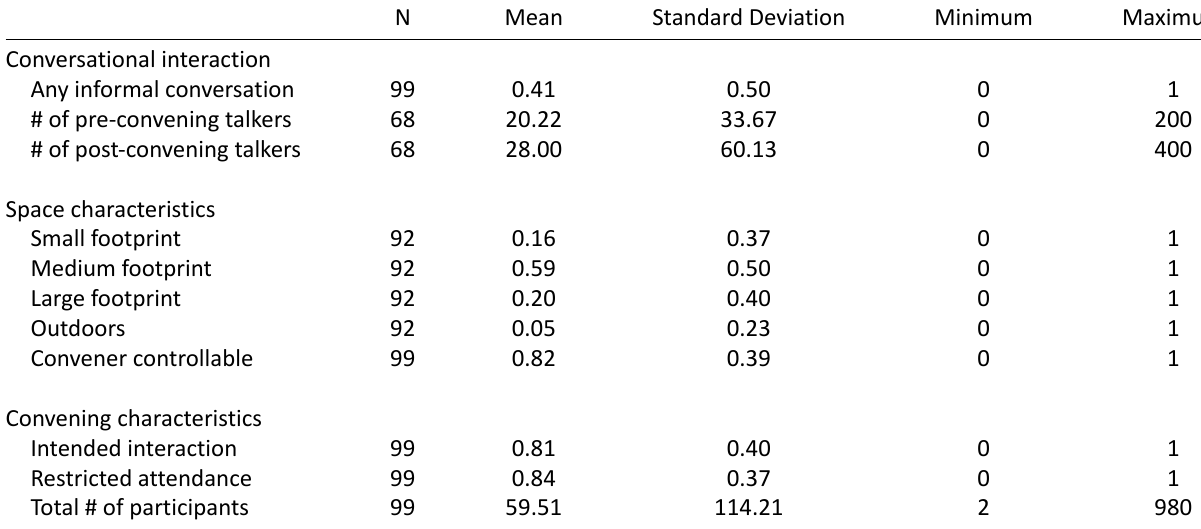
Table 1. Descriptive statistics for interactions, space characteristics, and convening characteristics.